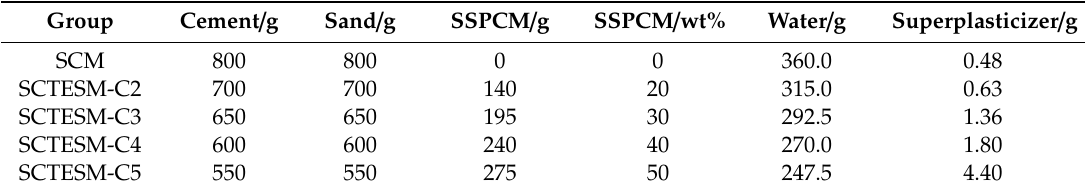
Table 1. Mixing proportion of sulphoaluminate cement-based thermal energy storage material